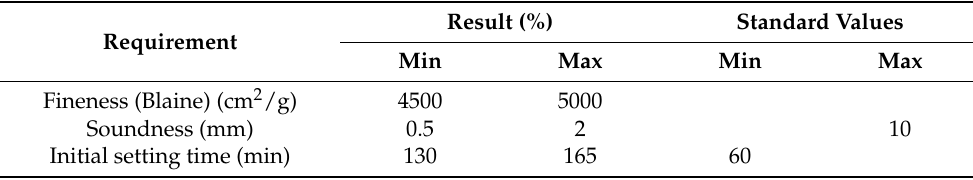
Table 1. Cement technical